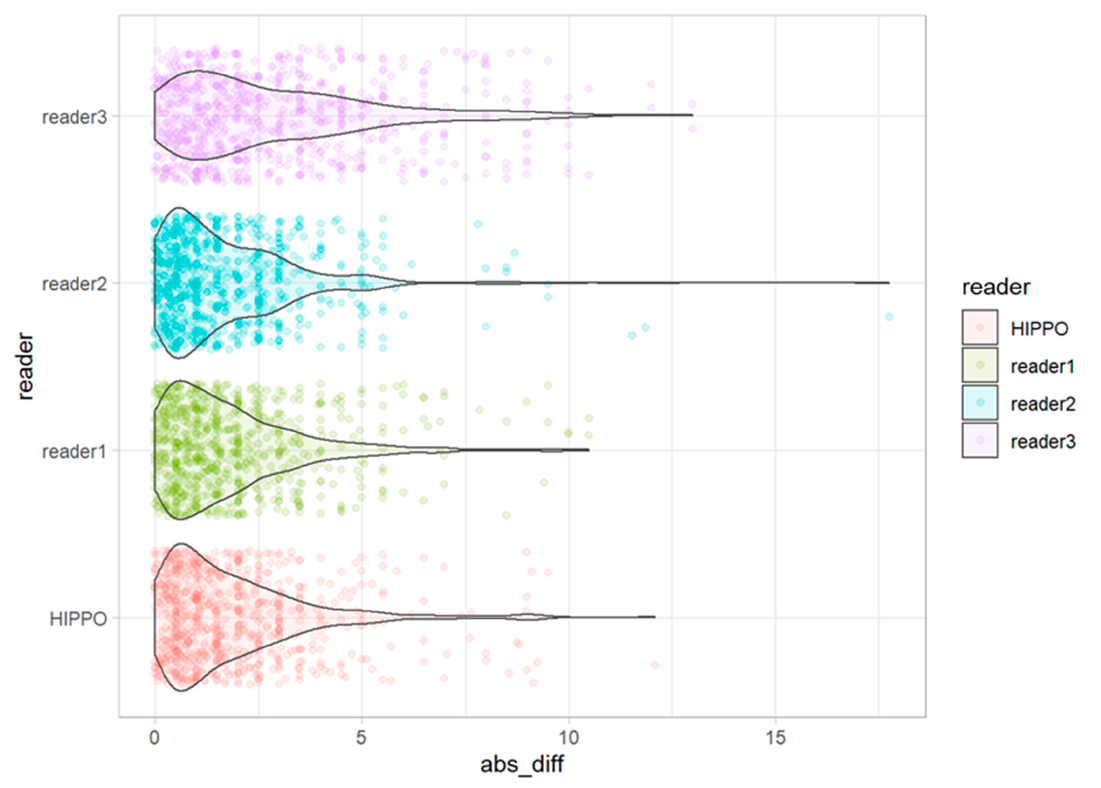
Figure 7. Absolute deviation from the median for each individual observation for all readers and HIPPO™.